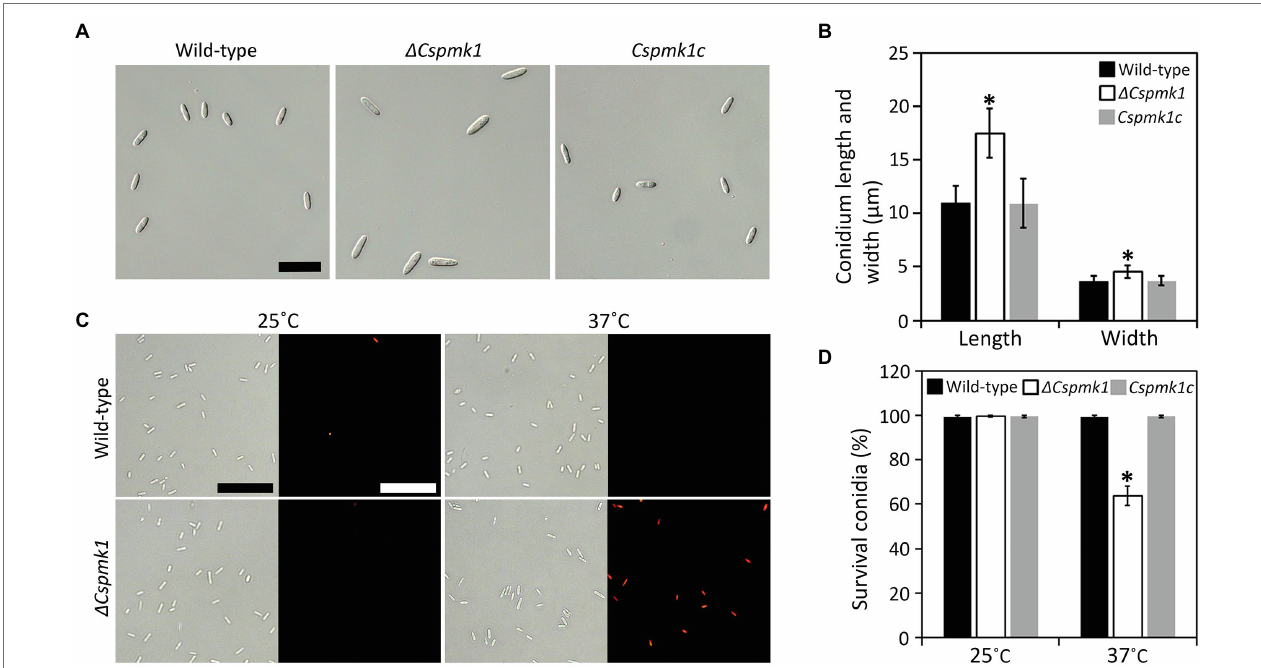
FIGURE 2 | CsPMK1 is important for conidium morphology and conidium viability under heat shock. (A,B) Morphology of conidium. (A) Photographs of conidium. Conidia were harvested from 7-day-old oatmeal agar (OMA). Scale bar, 25 μ m. (B) Quantitative analysis of conidium size. Length and width were measured at least 100 conidia, harvested from 7-day-old OMA. (C,D) Conidium viability under heat shock. (C) Photographs of conidia stained with phloxine B. Conidia were incubated at 25 ° C or 37 ° C for 16 h and then stained with phloxine B (10 μ g ml − 1 ) for 30 min. Dead conidia showed red fluorescence through fluorescent microscope. Scale bar, 50